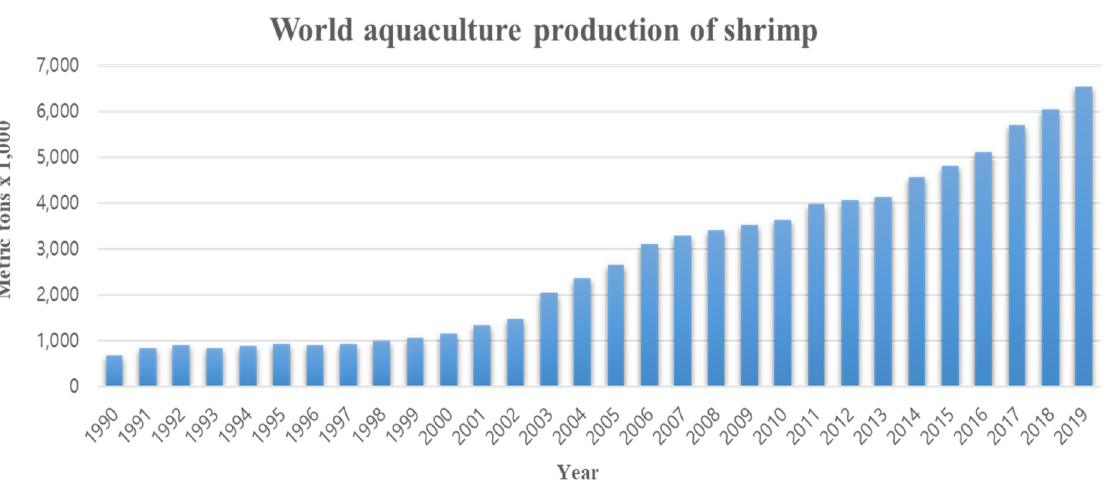
Figure 1. World aquaculture production of shrimp from 1990 to 2019 (Source: FAO yearbook of Fishery and Aquaculture Statistics).